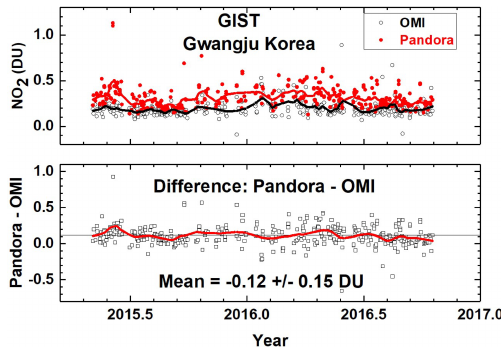
Figure 10. C ( NO 2 ) time series from Pandora (red) and OMI (black) for GIST University in Gwangju Korea and their differences. The comparison is formed from time coincidences between Pandora and OMI.